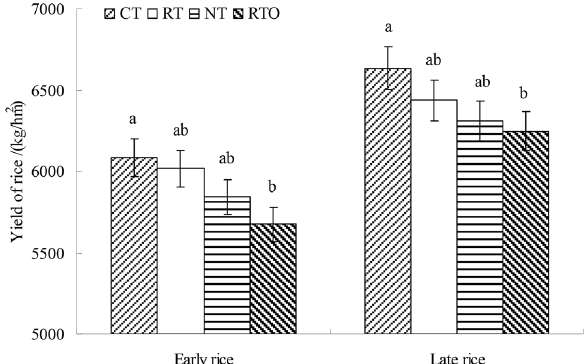
Figure 1. Grain yield of rice with different tillage treatments. CT conventional tillage with crop residue incorporation, RT rotary tillage with crop residue incorporation, NT no-tillage with crop residue retention, RTO rotary tillage with crop residue removed as control. Error bars were represented standard error of mean. Different smaller letters were indicated significantly difference at P < 0.05 level.